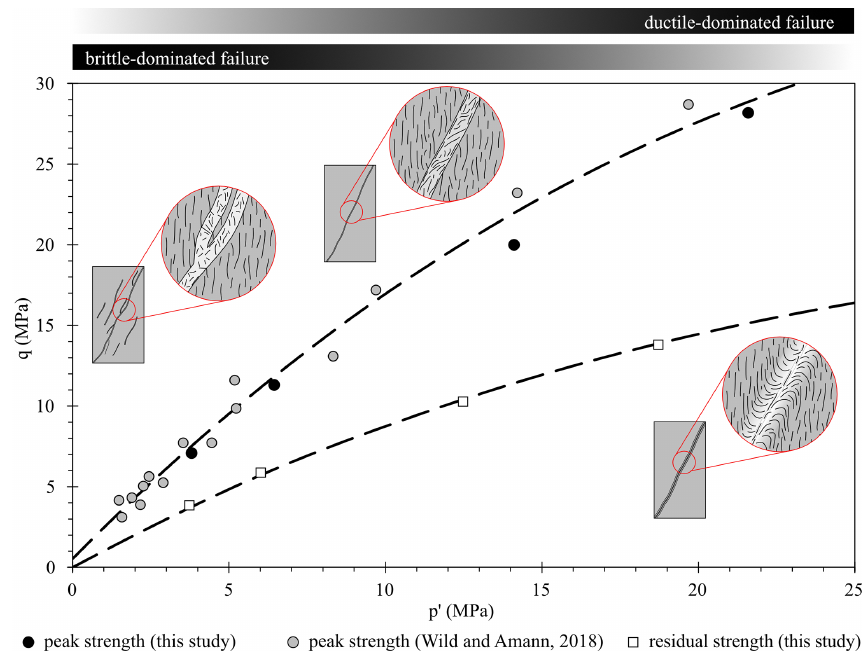
Figure 12. Peak and residual effective strength of shaly Opalinus Clay under triaxial undrained compression and our microstructural model for shear failure. The non-linear failure envelopes, fitted through all data points, underline the gradual transition for deformation microstruc- tures from brittle to ductile and the tendency for suppression of dilatancy due to the reduction in shear zone